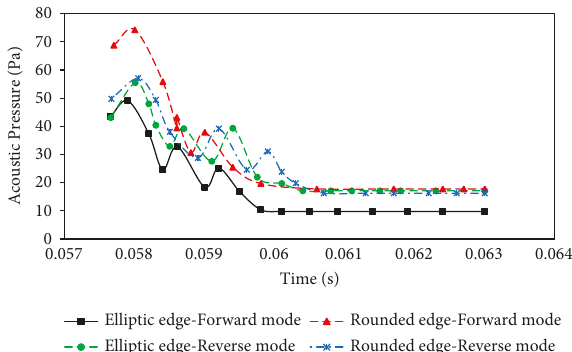
Figure 19: CFD results of the acoustic pressure vs. time at the receiver at an inlet velocity of 69.44m/s (train speed of 250km/h).